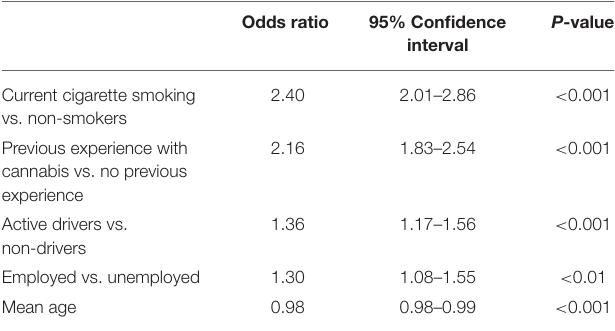
TABLE 3 | Frequency of adverse events at the 6-months follow-up questionnaire. Side-effects experienced due to the use of cannabis (4,891), no. (%)